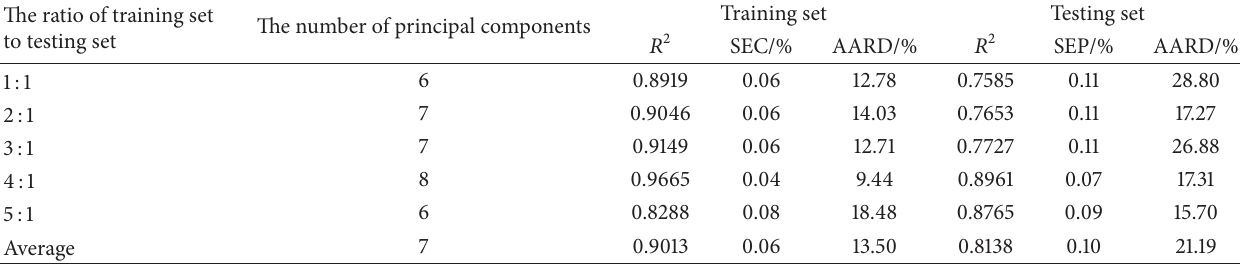
Table 3: Influence of different modeling ratios on prediction results of QPLS models for quantitative determination of germinability of Puccinia striiformis f. sp. tritici